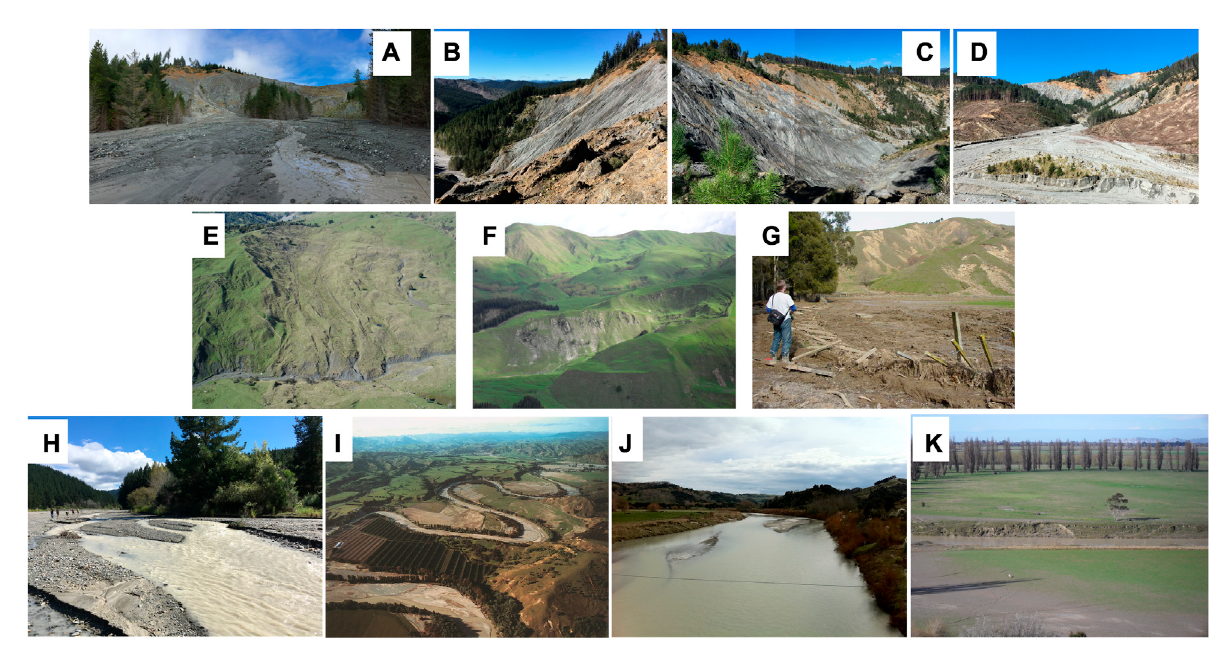
FIGURE 9 The Waipaoa River is a globally signi fi cant example of an overloaded channel with exceedingly high sediment fl ux. Deforestation and subsequent forest management has created an Anthropocene riverscape that is prone to profound, rapid and recurrent geomorphic adjustment. The river changes downstream from a rapidly aggrading bedload to an aggrading suspended load dominated river. Gully mass movement complexes and landslips induce rapid fan and valley fl oor aggradation. Despite the buffering effects of terraces and fans, sediment stores along channels are readily reworked in this system that maintains high connectivity fromtheMountainsto theSea. DramaticlandscapesofWaipaoaCatchment. (A) upper Tarndale fan, (B) Tarndale gully, (C) Mangatugully, (D) Mangatufan, (E) earth fl ow, (F) deepseatedlandslide, (G) shallowlandslide(courtesyMikeCrozier), (H)